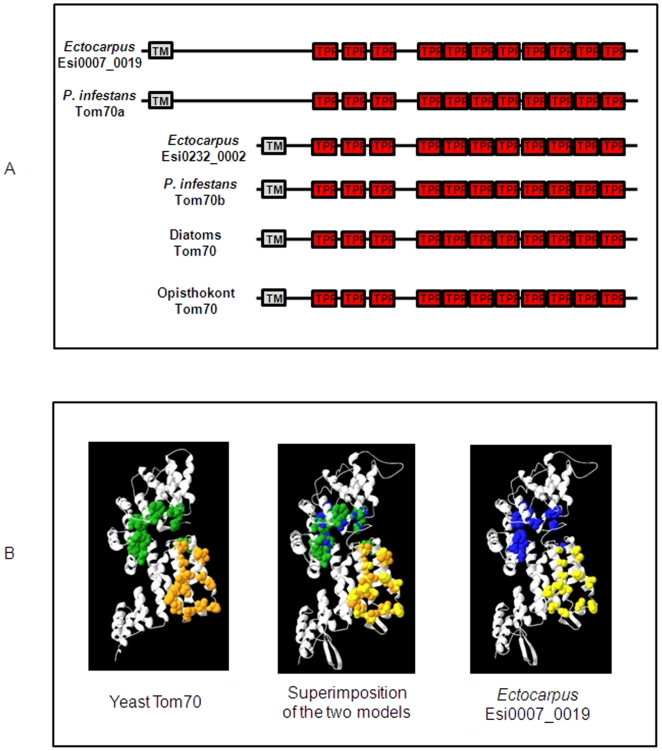
Description of the Tom70 homologues found in stramenopiles.
(A) Comparison of the different domain structures found in Tom70 homologues in Ectocarpus, oomycetes and diatoms. Transmembrane and TPR domains regions are shaded in grey and red respectively. (B) Model of the Ectocarpus Esi0007_0019 protein obtained using the yeast Tom70 crystal structure (pdb accession: 2GW1) as a template. Residues implicated in substrate binding are coloured in green and blue for yeast and Ectocarpus, respectively. Residues involved in dimerisation are coloured in orange and yellow for yeast and Ectocarpus, respectively. The Esi0007_0019 model was generated in alignment mode on the SIB website and the pdb file was compared to yeast Tom70 using pdbViewer software. The superimposition of the two models (middle panel) shows the degree of conservation of key amino acids between the two proteins.